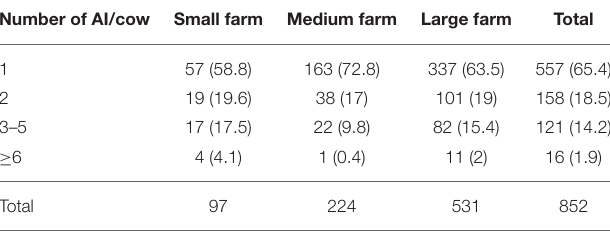
TABLE 6 | Number of artificial insemination given per cow by farm-size